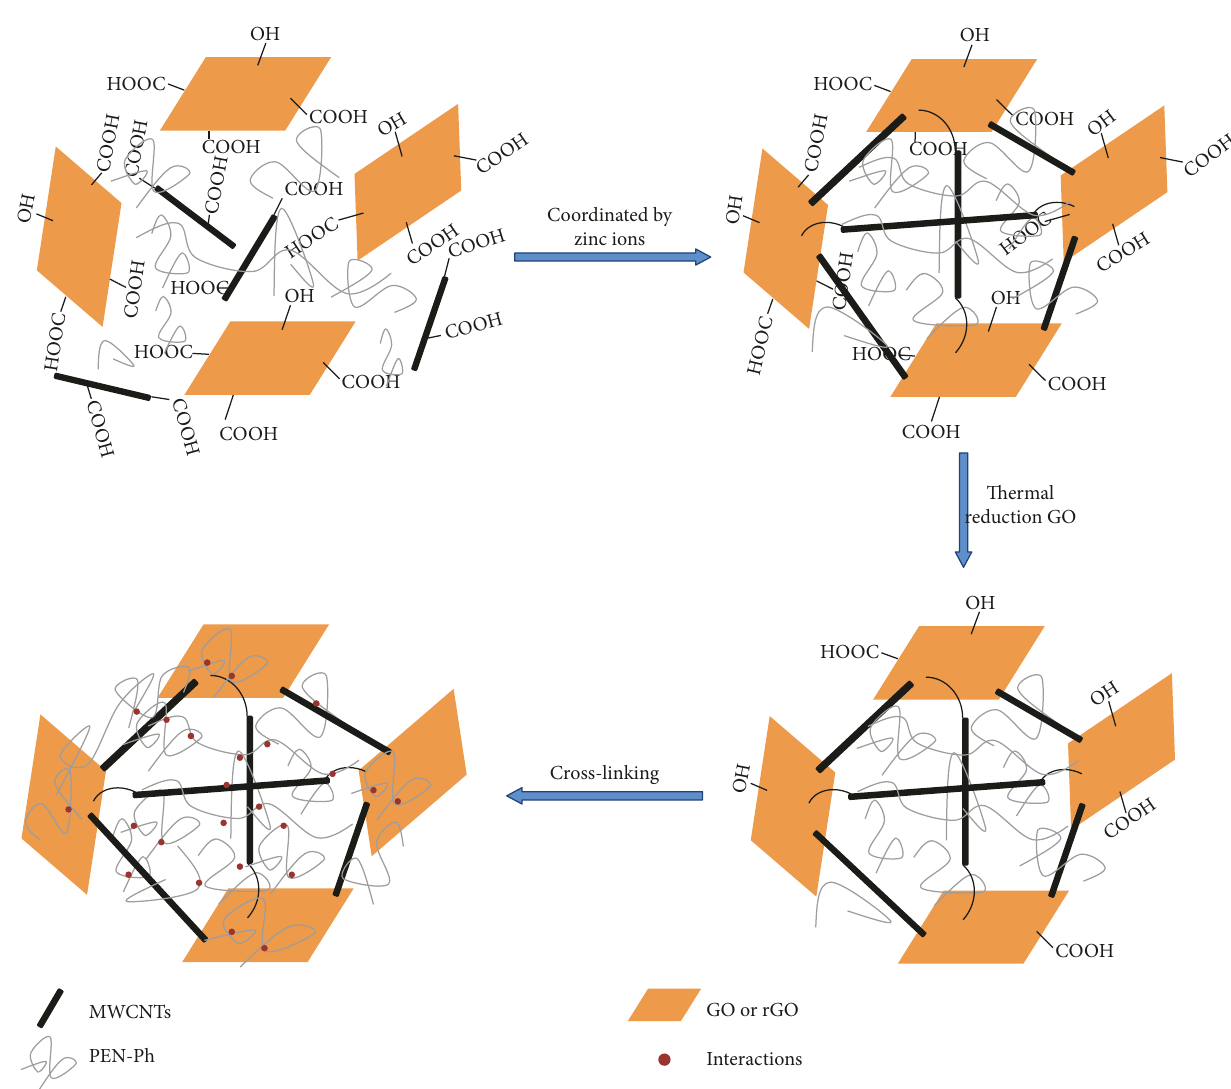
Figure 10: Fabrication route for